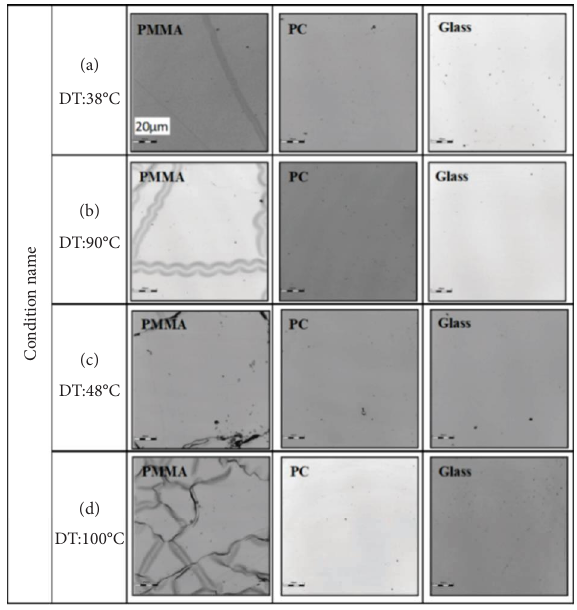
Figure 3: Surface laser micrographs (A–D) of copper oxide flms that formed with 10W and 30 W power at room temperature and 45 ° C in an infrared lamp